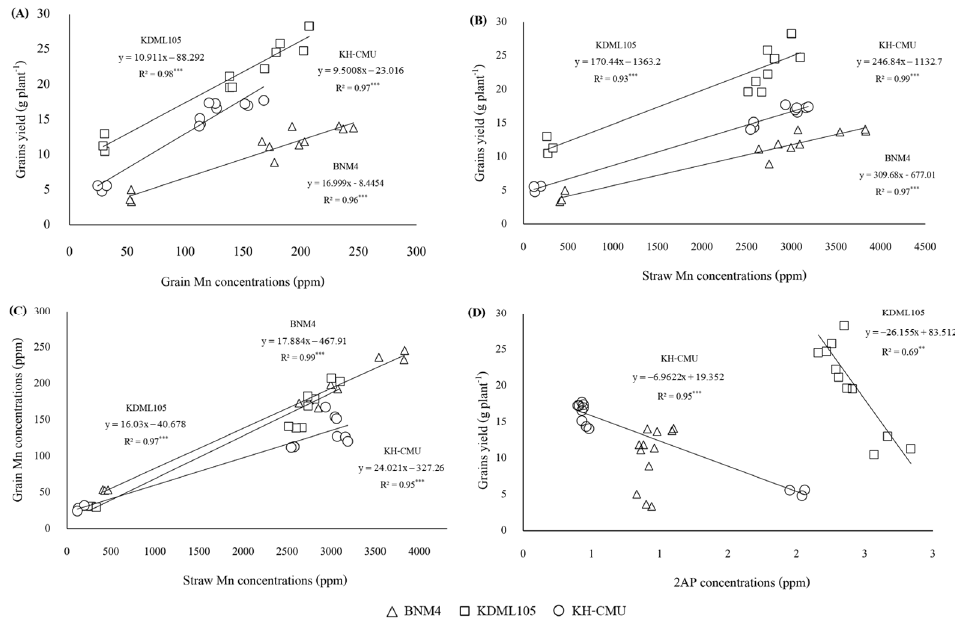
Figure 5. Correlation between grain yield and Mn concentration in grain ( A ), between grain yield and Mn concentration in straw ( B) , between Mn concentration in grain and Mn concentration in straw ( C ) and between the grain yield and 2AP concentration ( D ) of different Thai fragrant rice varieties. *** Significantly different at p < 0.001.